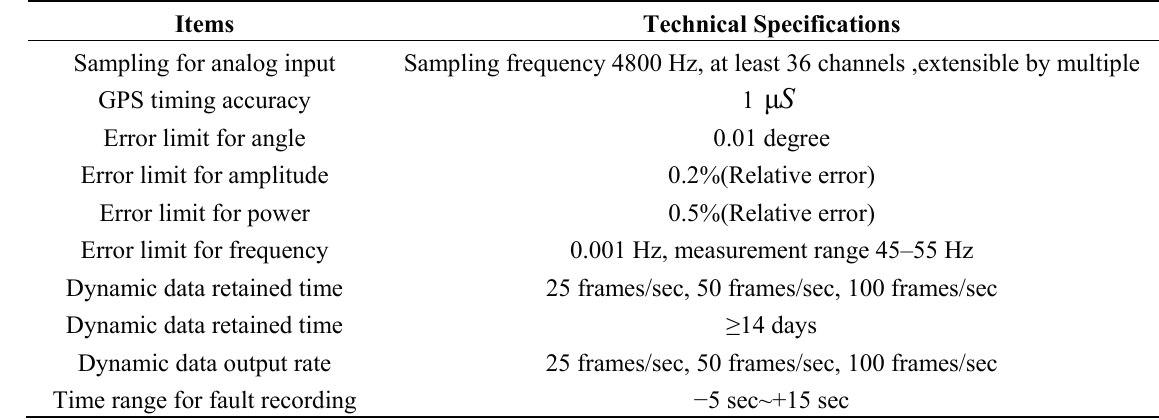
Table 1. The primary technical specifications of Phasor Measurement Unit.